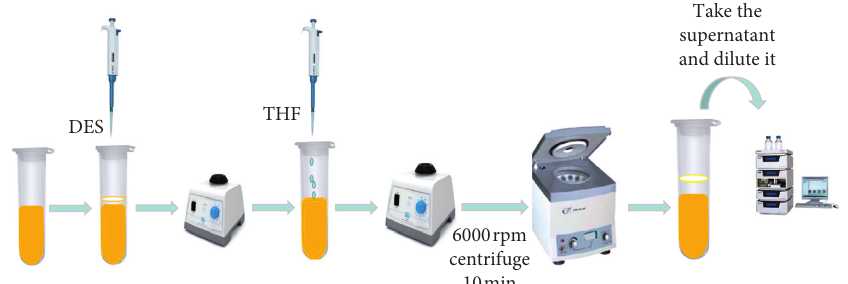
Figure 1: Deep eutectic liquid-phase microextraction process.